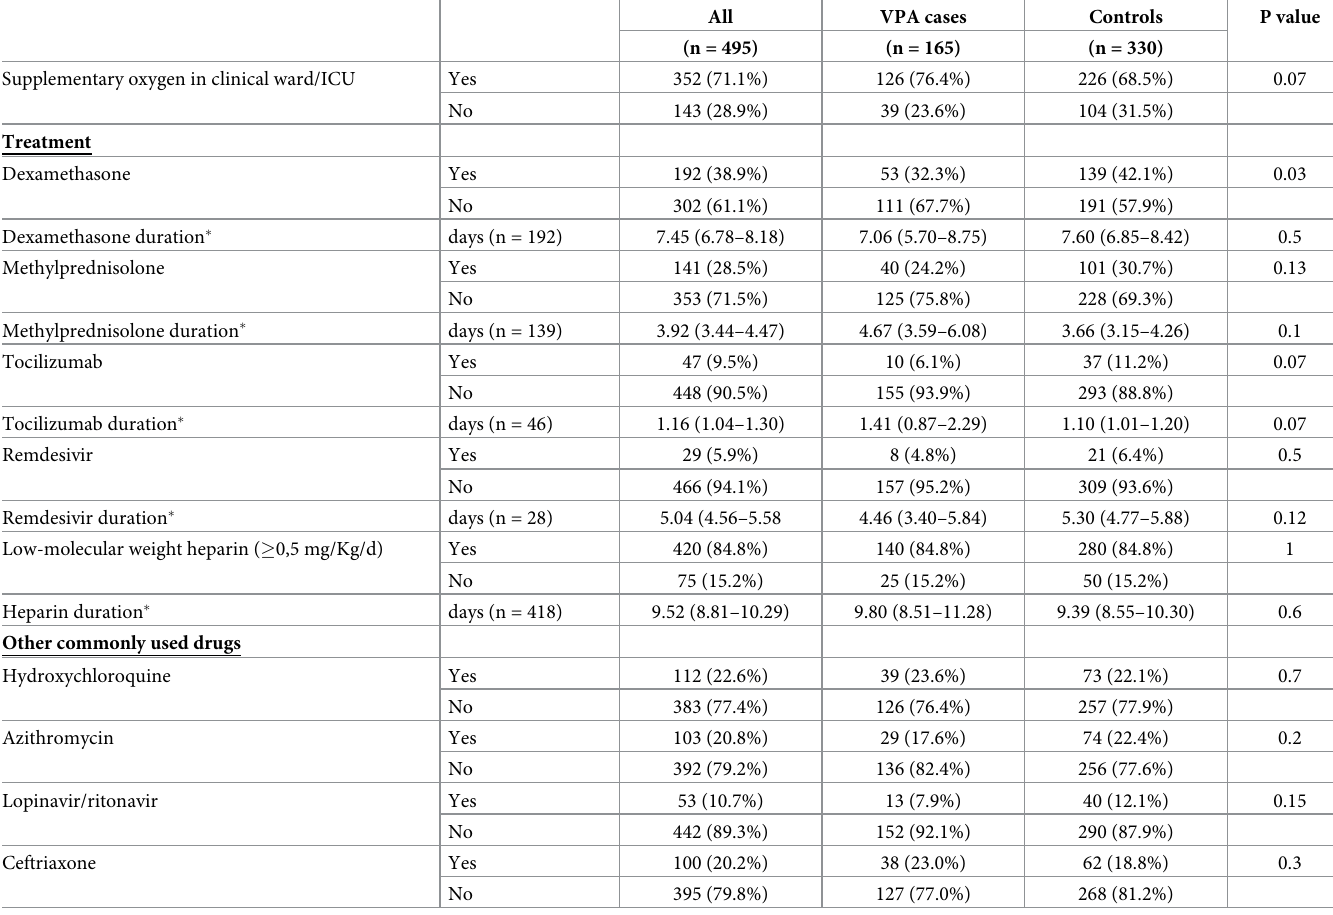
Table 3. In-hospital management and